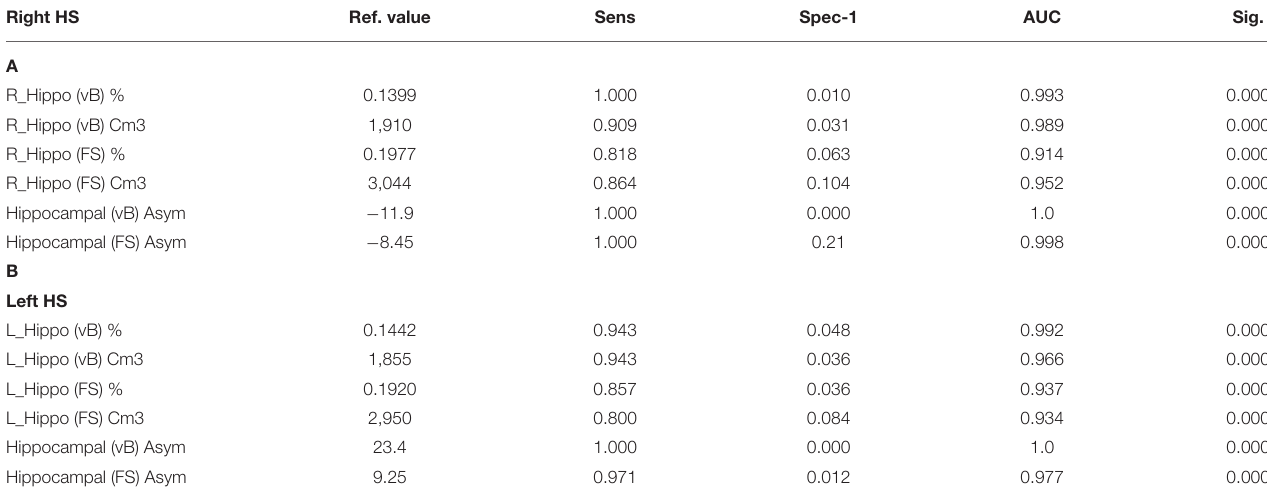
TABLE 3 | ROC curve: reference values for highest sensitivity and specificity detection for right (A) and left (B) HS; using hippocampal volumes and asymmetry values from both methods. Right HS Ref. value Sens Spec-1 AUC